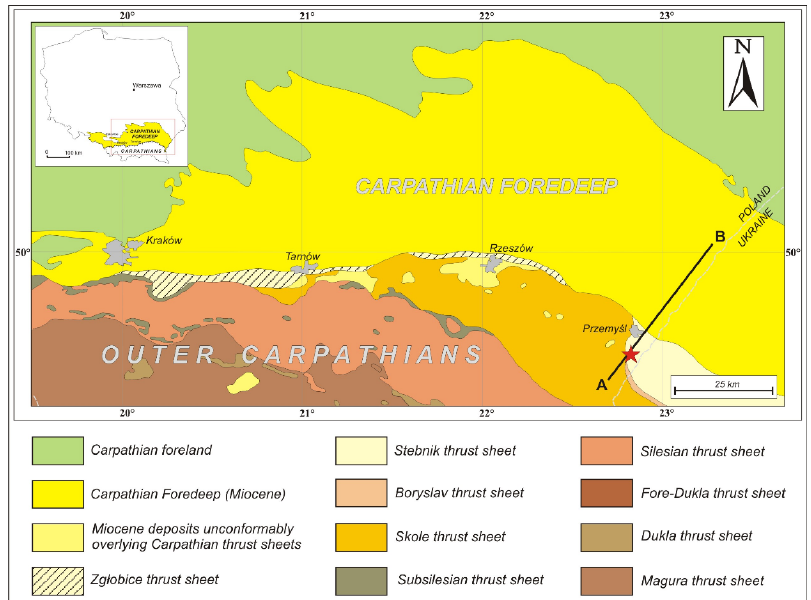
Figure 1. A simplified geological map of the Outer Carpathians and their foreland between Kraków and Przemy´sl. The A–B cross-section is shown in Figure 3. Red star: approximate location of the Huwniki-1 well.